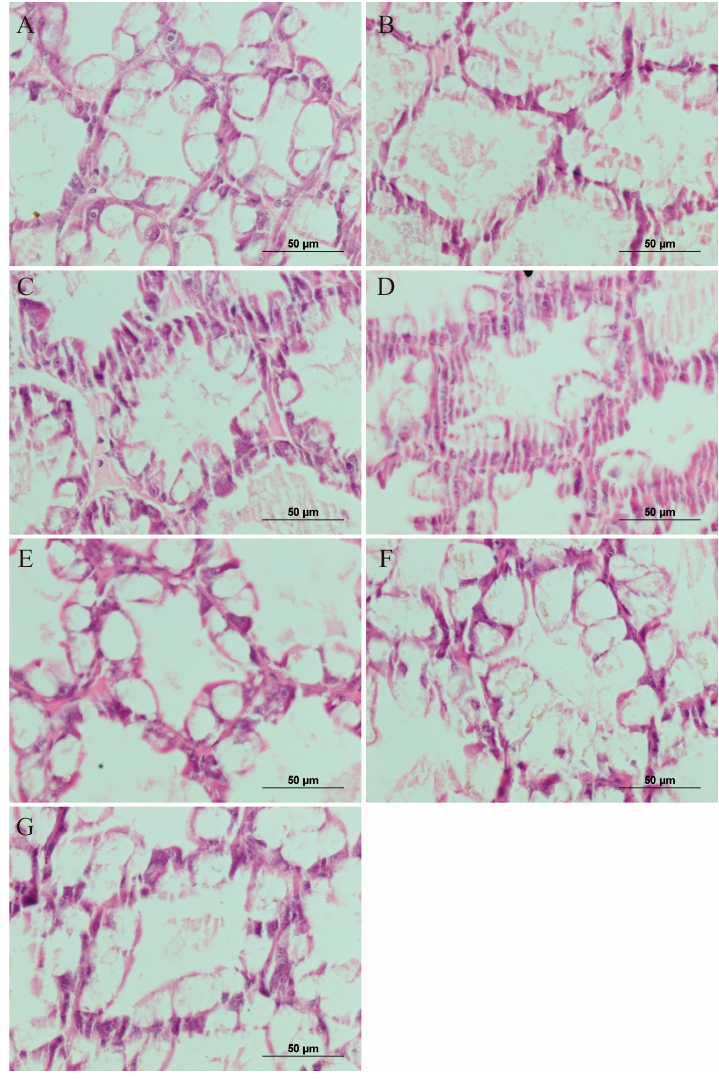
Figure 6. Changes in the histology of drug-treated L. vannamei hepatopancreases at 5 days. ( A ) Control, ( B ) infection only, ( C ) florfenicol, ( D ) quercetin, ( E ) LDC, ( F ) MDC, and ( G ) HDC group. Scale bar = 50 µ m. Table 3. Two-way ANOVA analysis of cumulative mortality, protection ratio, Vibrio density and immune parameters with florfenicol and quercetin.